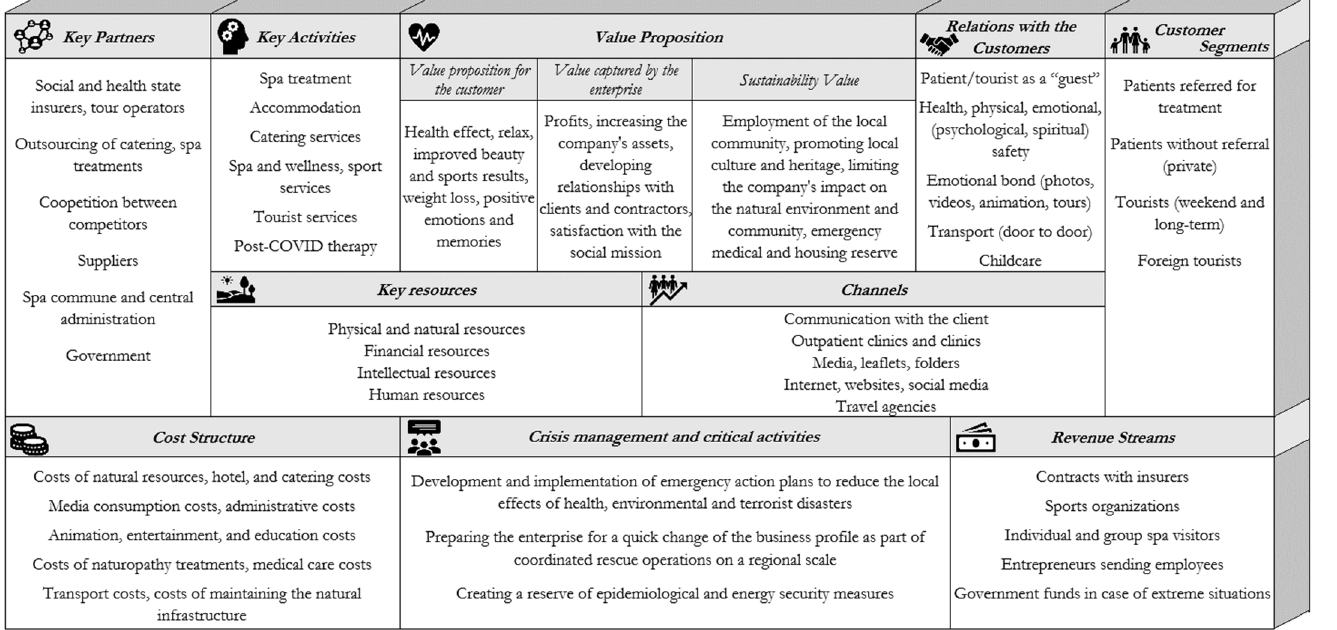
Figure 2. Sustainable business model of a spa tourism enterprise. Source: Own study.